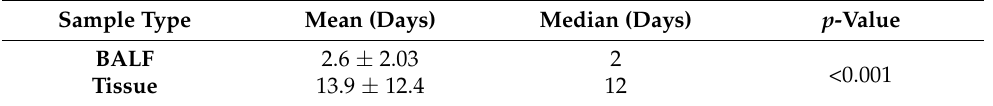
Table 4. Comparison of the turnaround time of EGFR mutation testing using BALF vs. tissue